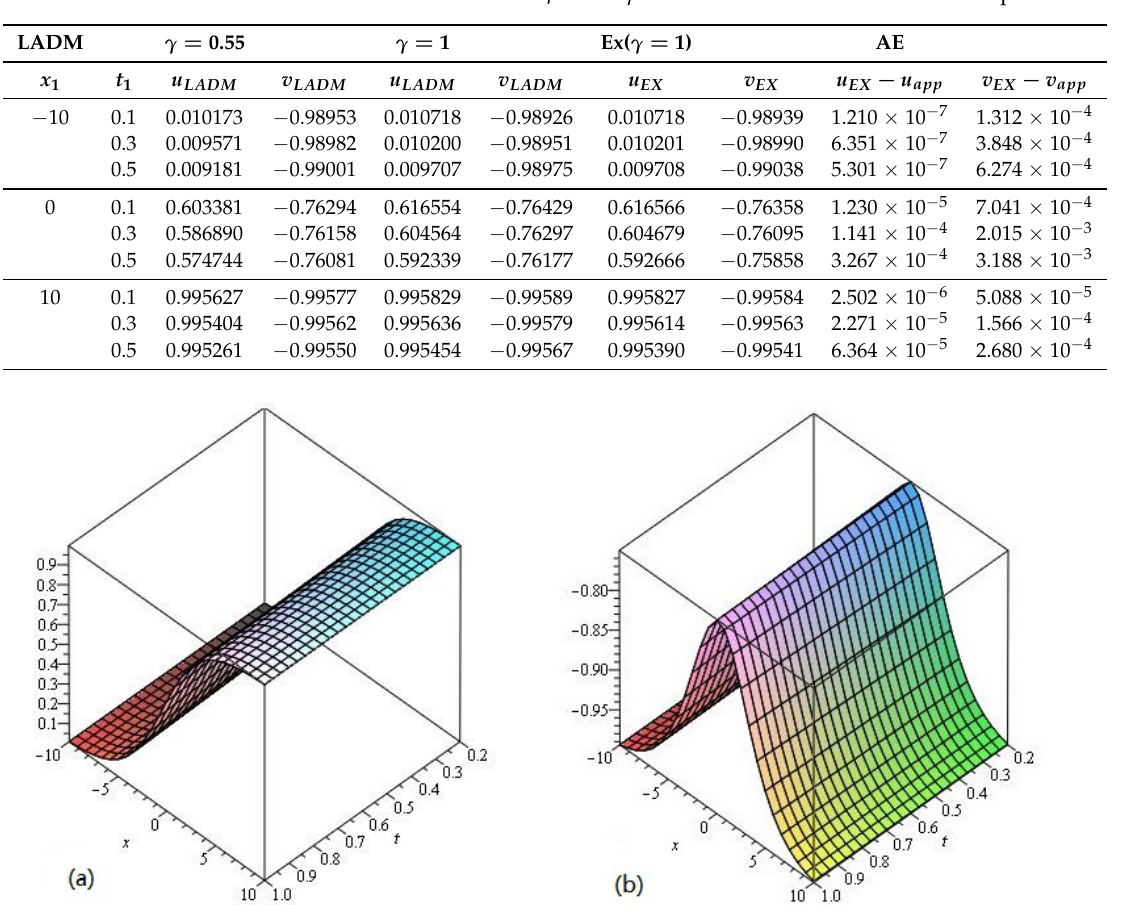
Figure 3. The LADM solution of ( a ) u ( x 1 , t 1 ) and ( b ) v ( x 1 , t 1 ) of Example 2 at γ =